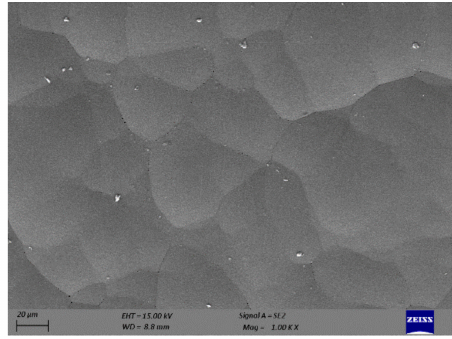
Figure 4. SEM image of as-plated surface.